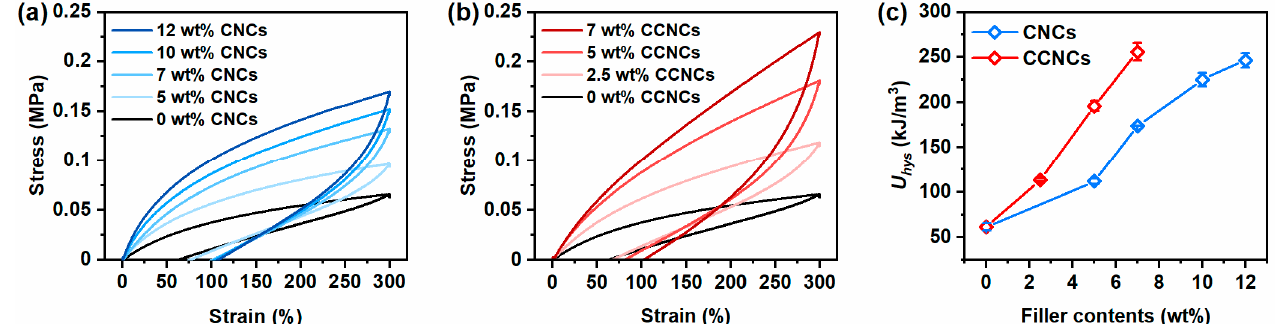
Figure 5. ( a , b ) Loading–unloading curves of the nanocomposite hydrogels using different concentrations of CNCs or CCNCs. ( c ) Dissipated energies ( U hys ) for CNCs (blue) and CCNCs (red).